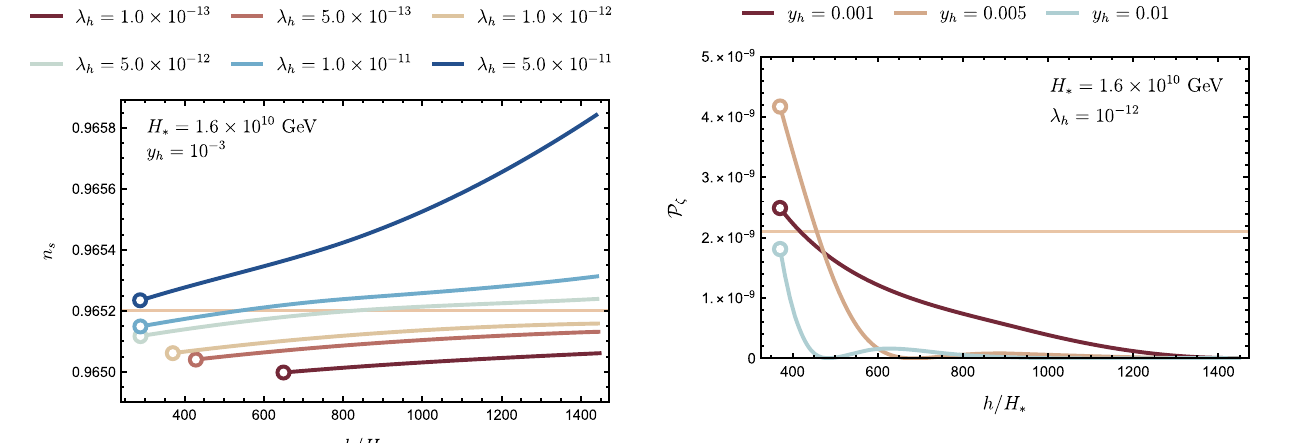
Fig. 4 The dependence of P ζ on the Yukawa coupling y h . The hori- zontal line indicates the central value of the Planck data